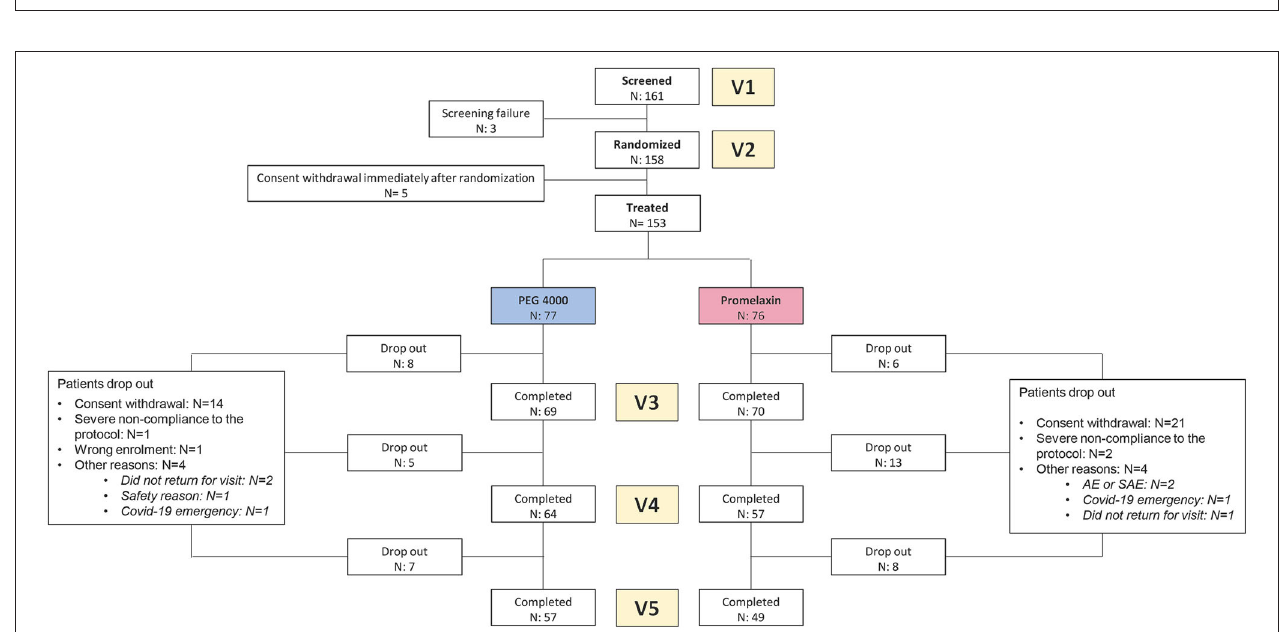
FIGURE 2 | CONSORT diagram. The figure shows the Consort Diagram of the randomized trial.